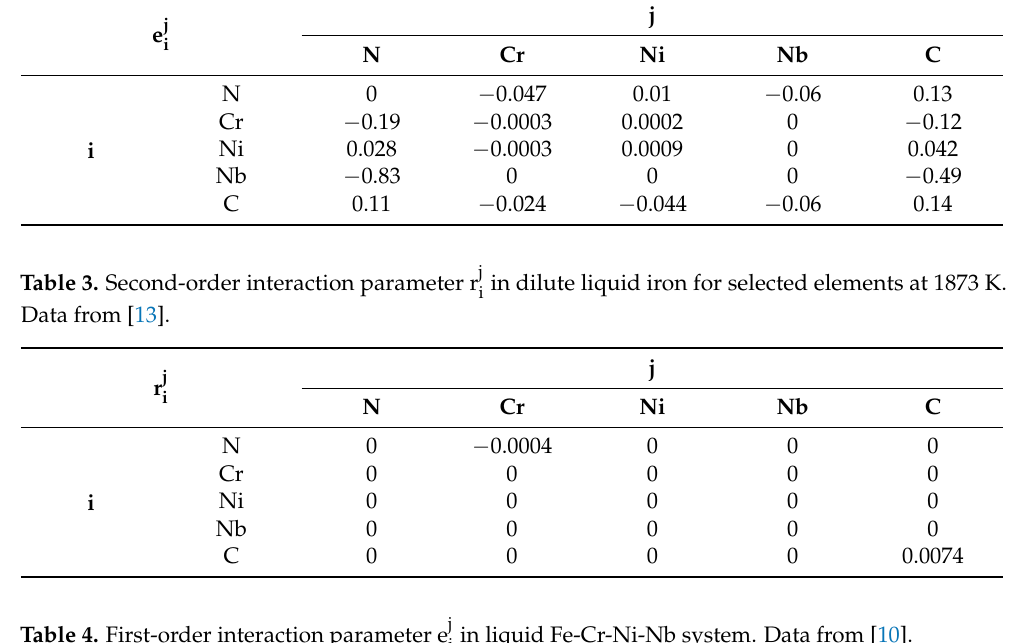
Table 4. First-order interaction parameter e j